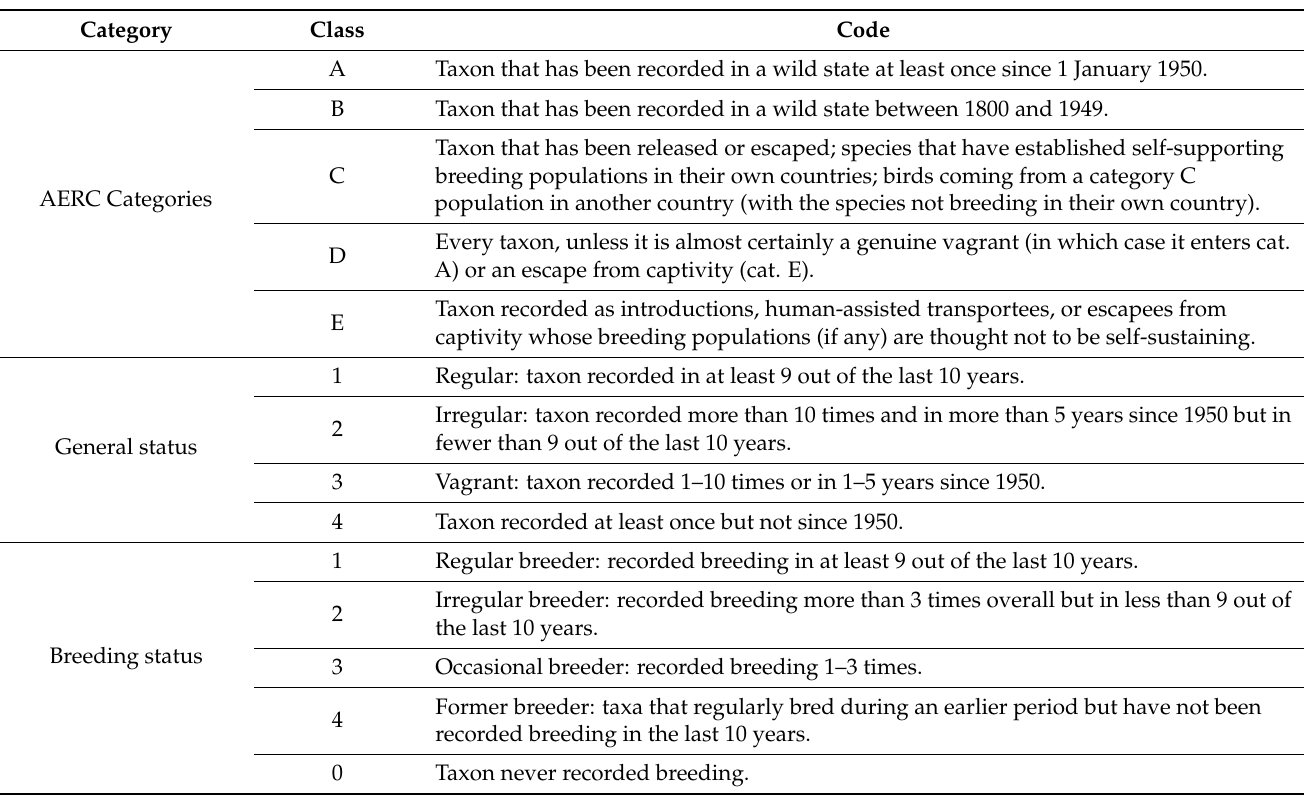
Table 1. Alpha-numeric codes were adopted for each taxon belonging to the GCL (1685–2022) (see text for